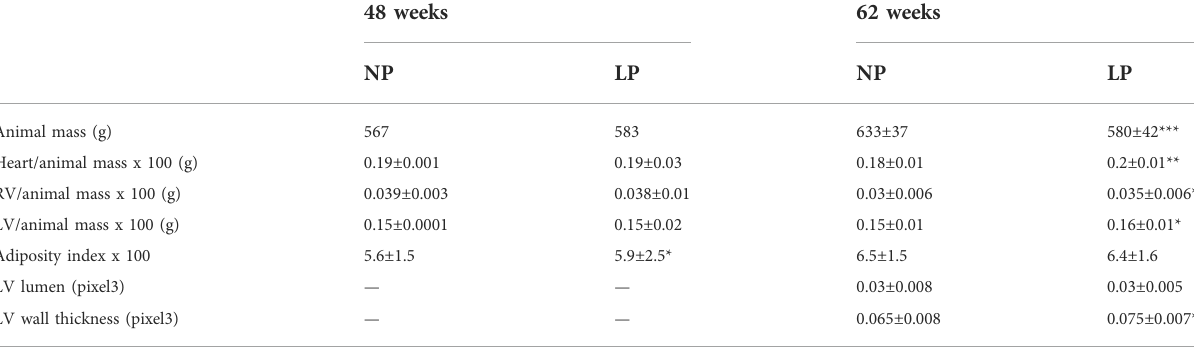
Frontiers in Cell and Developmental